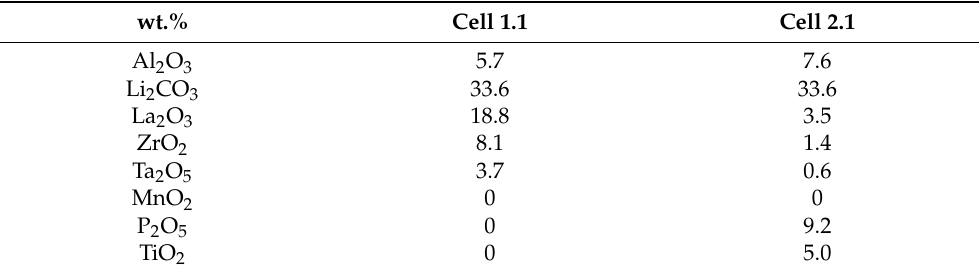
Table 1. Considered slag-forming oxides from possible battery cell compositions based on Schwich et al.